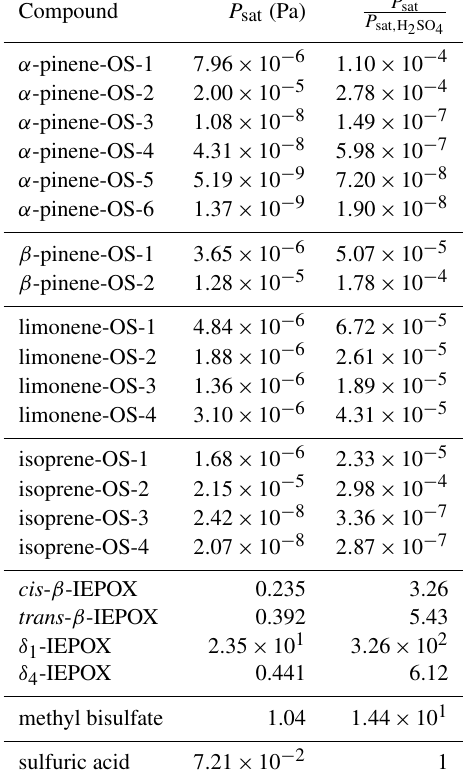
Table 1. Estimated saturation vapor pressures of the pure com- pounds and the ratio between the saturation vapor pressures of the organic compound and sulfuric